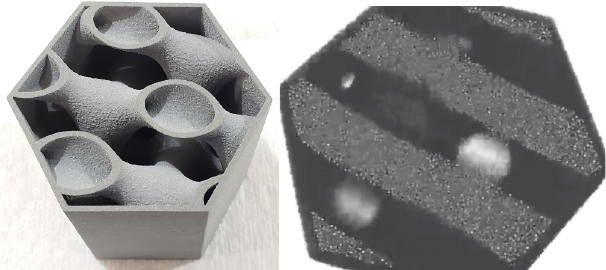
Figure 3. An example of design flexibility for coolant flow optimization (left) and an example tomogram of embedded particle distributions within this geometry